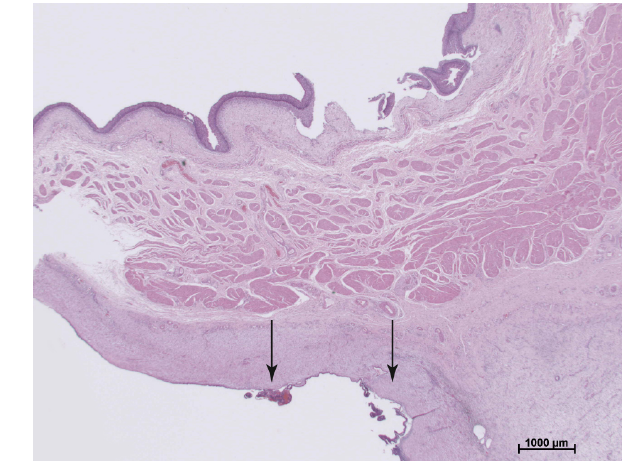
Figure 3. Urinary bladder of rhesus macaque with endometrial le- sions. The serosa is infiltrated by endometrial glands, endometrial stroma, and inflammatory cells (hematoxylin and eosin